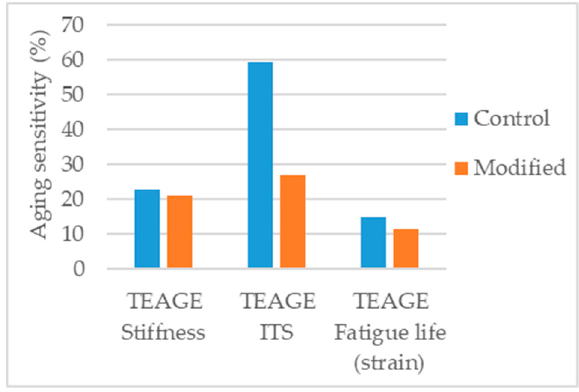
Figure 17. Aging sensitivity of the parameters considered in the study [131].